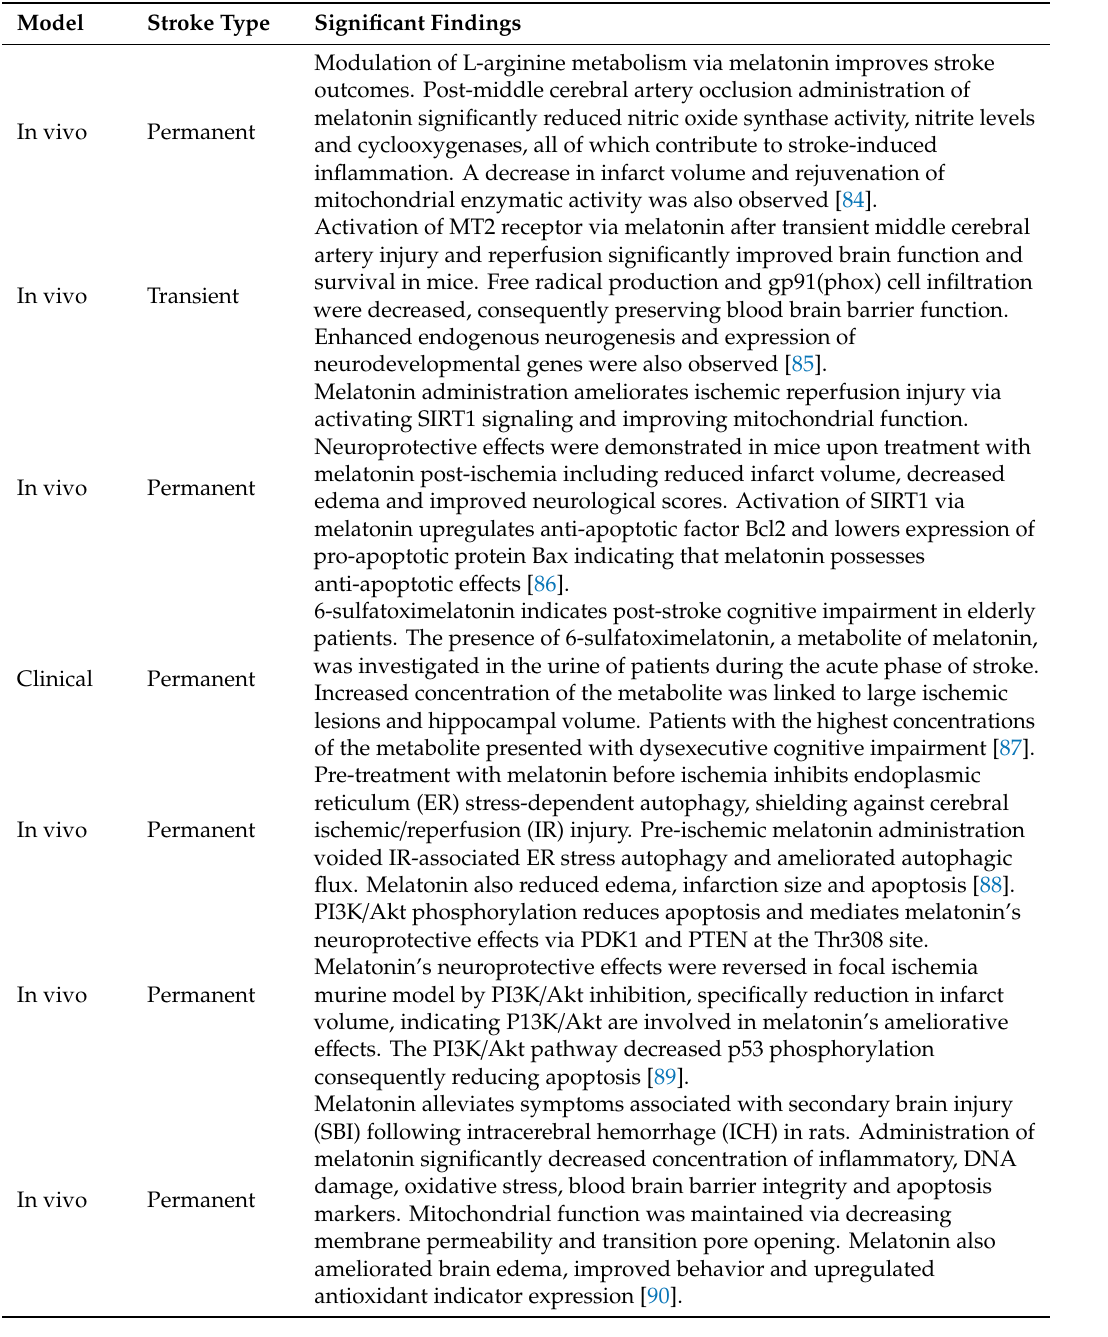
Table 1. Melatonin Neuroprotection in Stroke. This table displays milestone discoveries highlighting melatonin as a potent therapeutic in